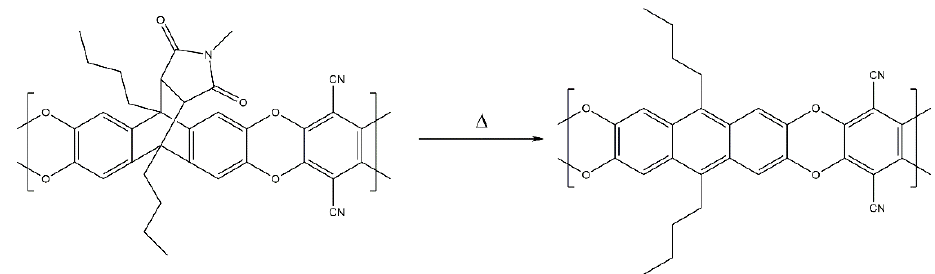
Figure 7. Expected thermal conversion of methyl-100 at 250 °C.